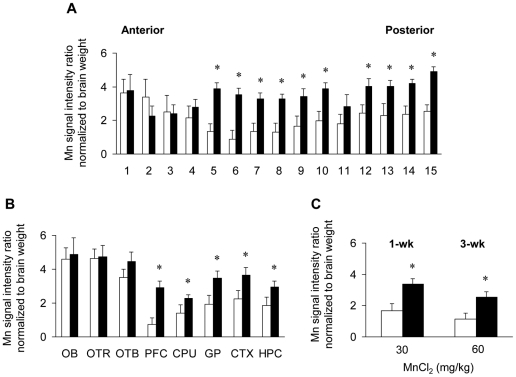
Effects of iron deficiency on manganese accumulation in the brain after intranasal instillation.After intranasal instillation of MnCl2 (3×10 mg/kg for 1 wk or 6×10 mg/kg for 3 wks), a signal intensity ratio of brain to the background for each image was calculated and corrected for endogenous signal intensity of respective diet group and then normalized to brain weight and dose. Manganese distribution in the axial sections of the brain tissue (A), in specific brain regions (B) and in the whole brain integrating all sections (C) was compared between control and iron-deficient rats. Empty and closed bars represent water-instilled and MnCl2-instilled rats, respectively. Data were presented as mean ± SEM (N = 4–5). * P<0.05 between control and iron-deficient rats determined by two-sample t-test. OB, olfactory bulb; OTR, olfactory tract; OTB, olfactory tubercle; PFC, prefrontal cortex; CPU, caudate-putamen or striatum; GP, globus pallidus; CTX, cortex; HPC, hippocampus.